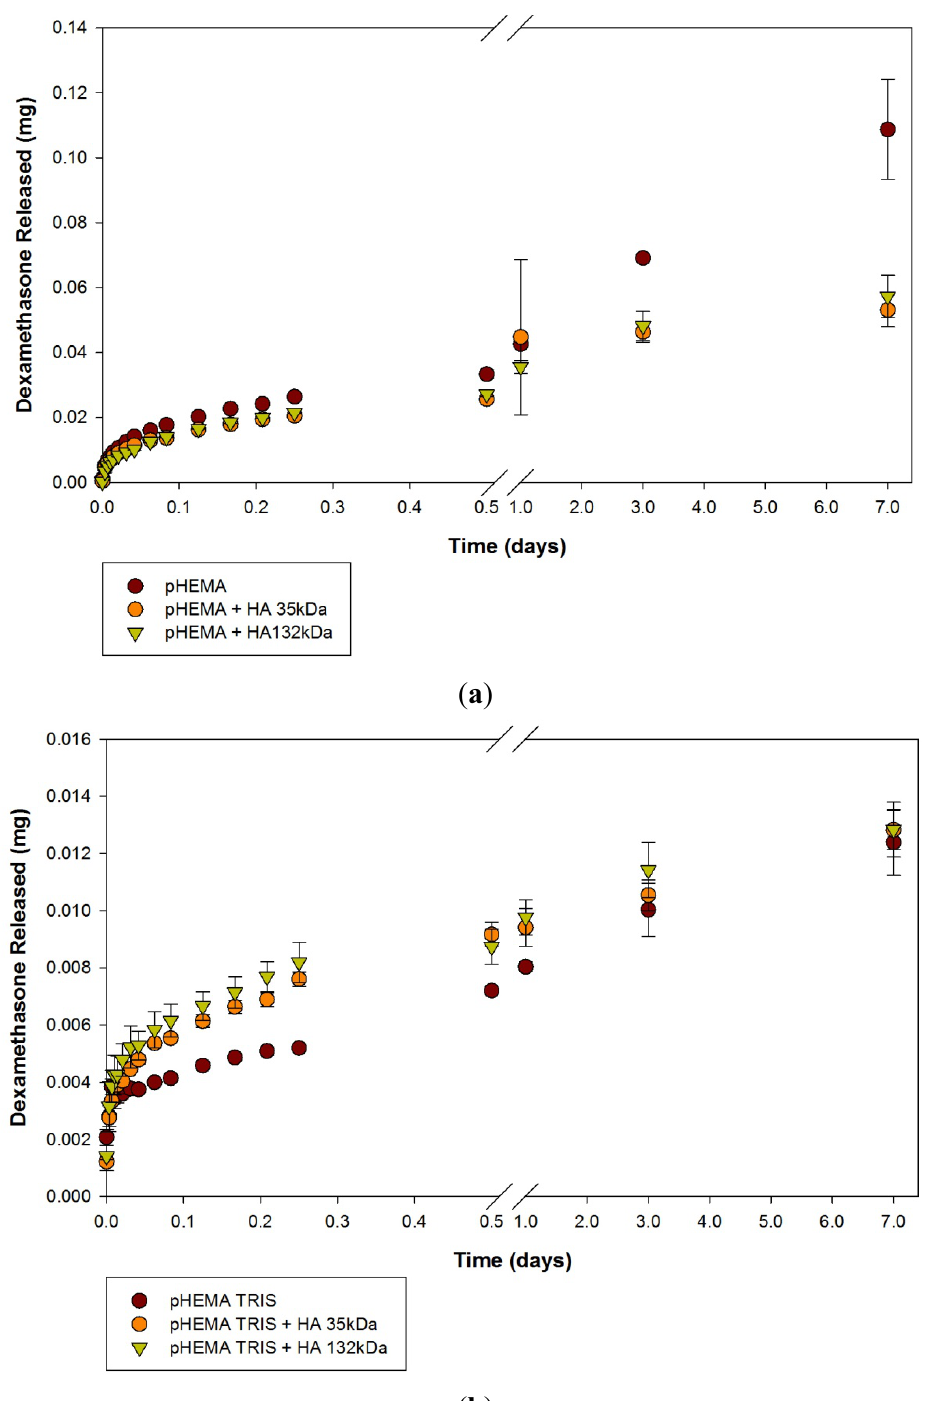
Figure 4. Dexamethasone phosphate release curves from ( a ) pHEMA, ( b ) pHEMA TRIS and ( c ) DMAA TRIS materials. Values plotted are means ± SD. HA 35 kDa = 35 kDa Hyaluronic Acid. HA 132 kDa = Hyaluronic Acid 132